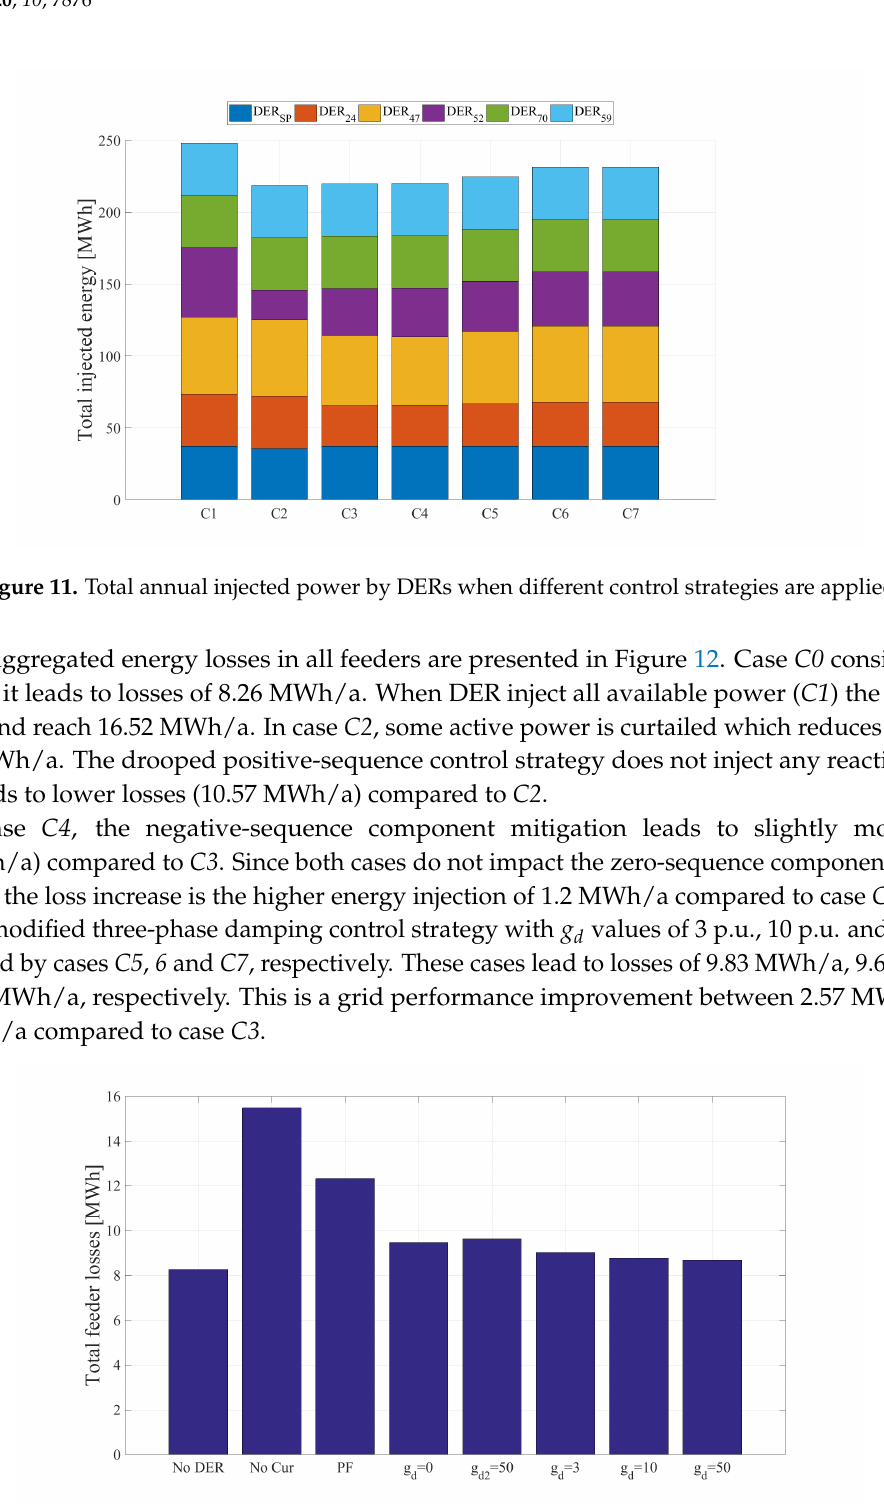
Figure 12. Total feeder losses when different control strategies are applied (No DER—C0, No Cur (No curtailment)—C1, PF (C2)—Variable power factor, g d = 0 (C3)—drooped positive-sequence control strategy, g d 2 = 50 (C4) damping control strategy VUF 2 only, g d = 3, g d = 10 and g d = 50